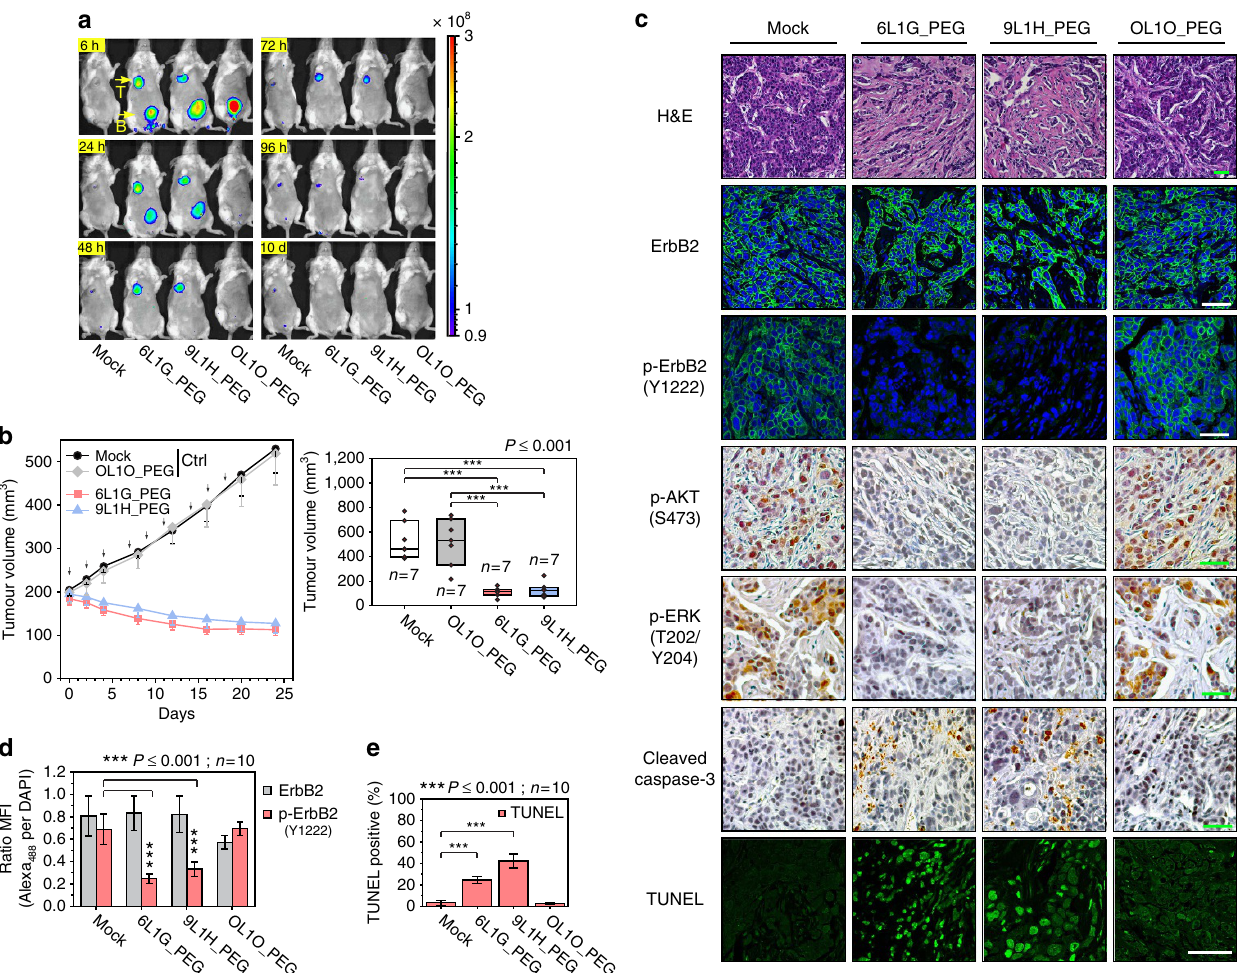
Figure 3 | Sustained inhibition of ErbB2 signalling triggers apoptosis in vivo. ( a ) Biodistribution analysis in BT474-xenografted mice, injected with Alexa 680 -conjugated and PEGylated DARPins or PBS (i.v.; 1mgkg (cid:2) 1 ). Mice were monitored on an IVIS imaging system for 10 days. Letters indicate tumour site (T) and bladder (B). ( b ) Tumour growth inhibition by PEGylated DARPins in SCID beige mice with pre-established BT474 xenografts. Left, treatment was started when tumours reached 200mm 3 . Agents were injected three times per week (i.v.; 20mgkg (cid:2) 1 ) as indicated by arrows. All error bars are s.e.m. Right, tumour size distribution of individual treatment groups after 24 d, for later time points see Supplementary Fig. 3C (two-sided, unpaired Students t -test). ( c ) In situ biomarker staining in treated BT474 xenografts. PFA-fixed, paraffin-embedded tumours were analysed by detecting the indicated cellular targets. Scale bars, 50 m m. ( d ) Per cent ErbB2 and p-ErbB2 (Y1222) staining intensity normalized to DAPI signal from ten tumour sections per treatment. ErbB2, p-ErbB2 and DAPI staining intensities were determined with ImageJ software (two-sided, unpaired Welch’s t -test). ( e ) Per cent TUNEL-positive cells from ten tumour sections per treatment. BT474 tumours were stained with TUNEL and counterstained with DAPI, the total number of single cells was identified by DAPI using Cell Profiler software, and associated TUNEL signals were quantified and assigned above a threshold (70 units) as